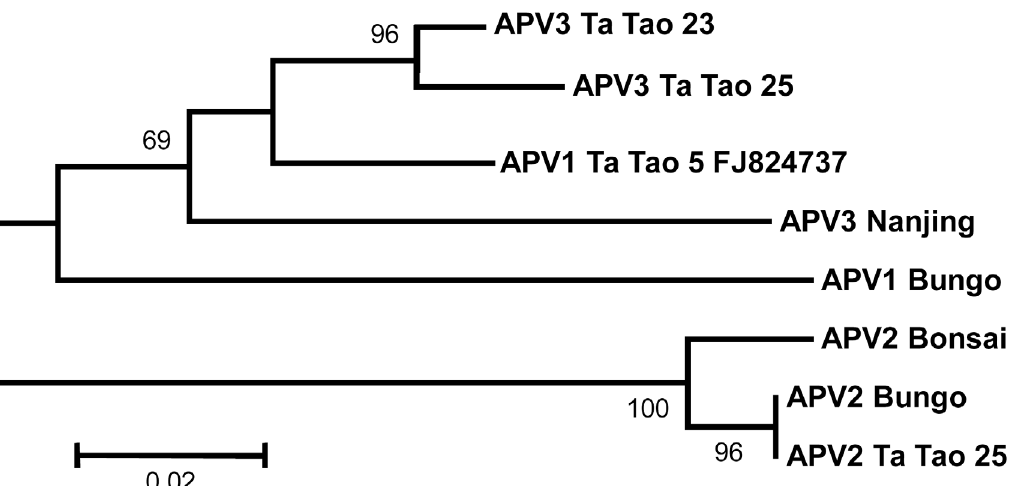
Fig 5. Unrooted phylogenetic tree reconstructed with the concatenated amino acid sequences of the Triple Gene Block proteins 2 and 3 of Asian prunus virus 1, 2, and 3 isolates. Tree was constructed by the neighbor-joining method and the statistical significance of branches was evaluated by bootstrap analysis (1,000 replicates). Only bootstrap values above 60% are indicated. The scale bar represents 2% amino acid